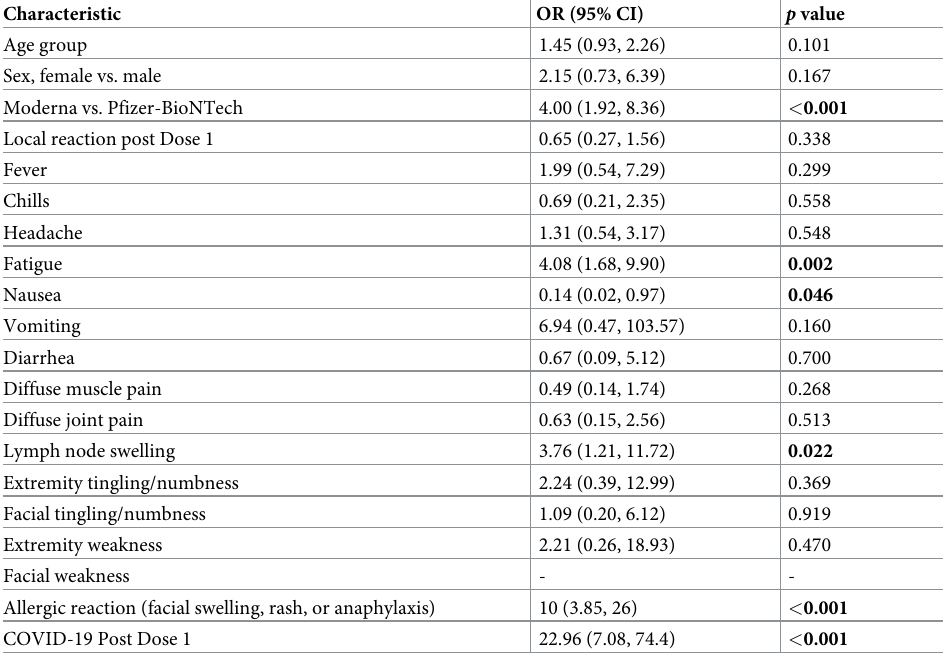
Table 5. Factors associated with incomplete vaccination.